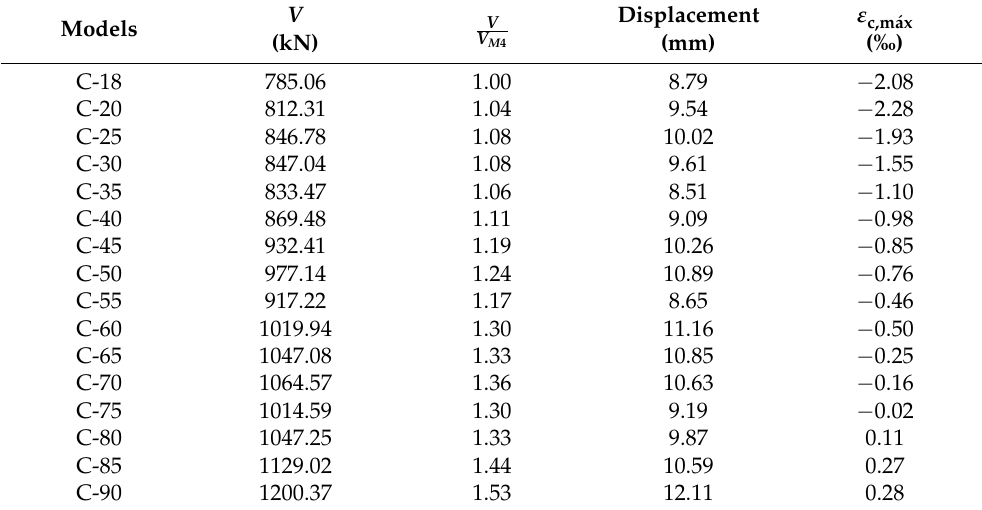
Table 5. Results obtained with Series